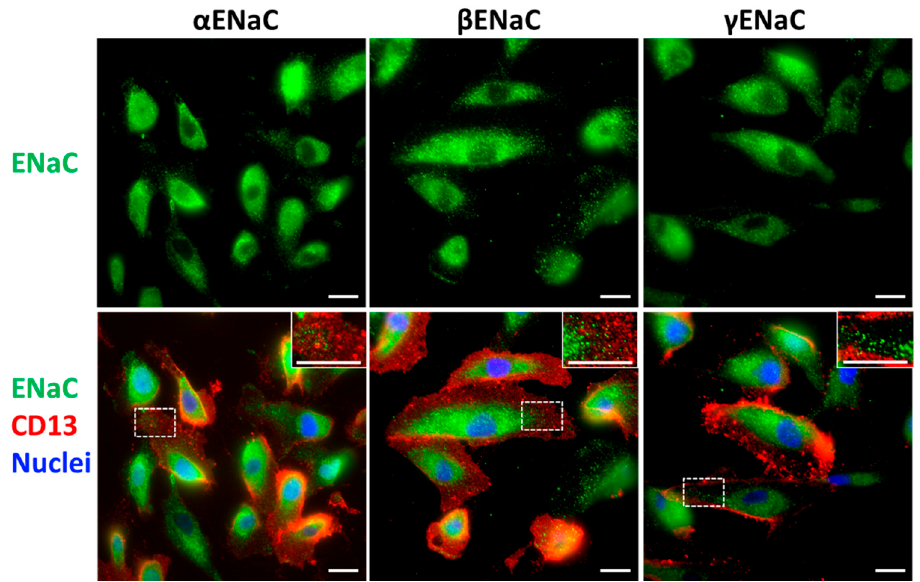
Figure 2. 𝛼 ENaC, β ENaC, and γ ENaC were stained in non-permeabilized primary urine-derived hRTC. 𝛼 ENaC, β ENaC, and γ ENaC were stained green. CD13 staining (red fluorescence) was seen on cell membrane as a punctate pattern. Nuclei were in blue. The detailed view was highlighted by dashed rectangle. (Scale bar = 10 µm.)